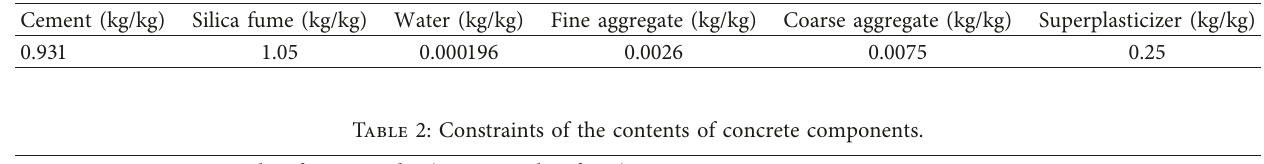
Table 1: Unit CO 2 emissions of the concrete components [11].